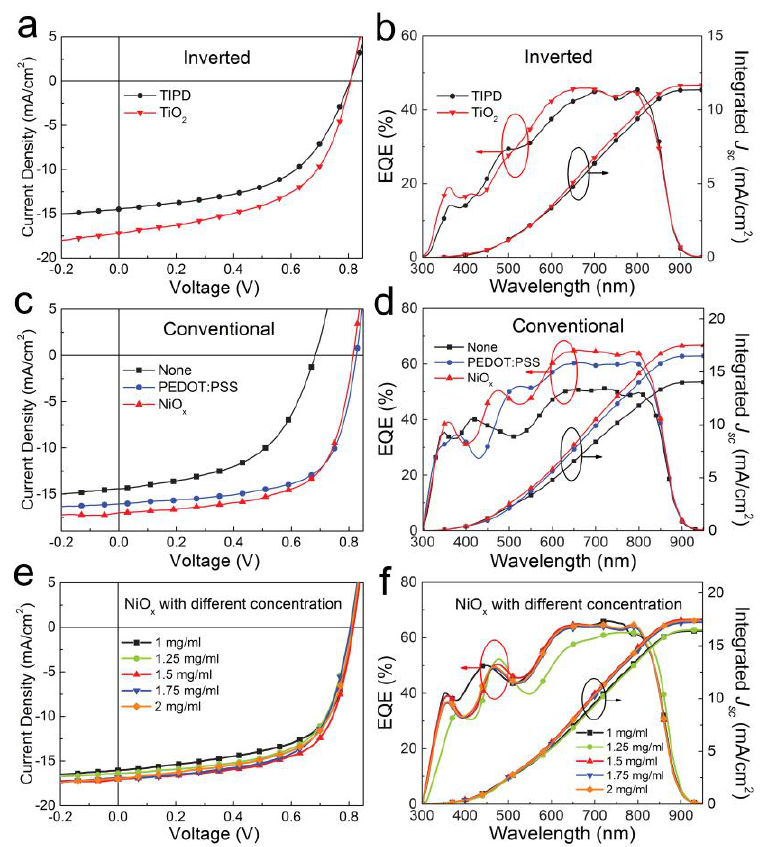
Figure 5. ( a ) Current density−voltage ( J–V ) and ( b ) EQE curves of inverted OSCs with TIPD and TiO 2 as cathode buffer layers; ( c ) J–V and ( d ) EQE curves of conventional OSCs without anode buffer layer, with PEDOT:PSS and with NiO x as anode buffer layers; ( e ) J–V and ( f ) EQE curves of conventional OSCs with different thickness of NiO x film as the anode buffer layer. Table 2. Device parameters of OSCs with different thickness of NiO x layer as the anode buffer layer. NiO x Concentration (mg/mL) J sc (mA/cm 2 ) V oc (V) FF (%) PCE (%) Average 1 16.38